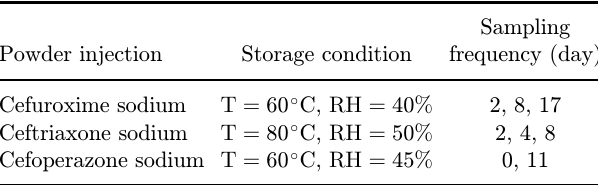
Table 1. Conditions for acceleration experiment.